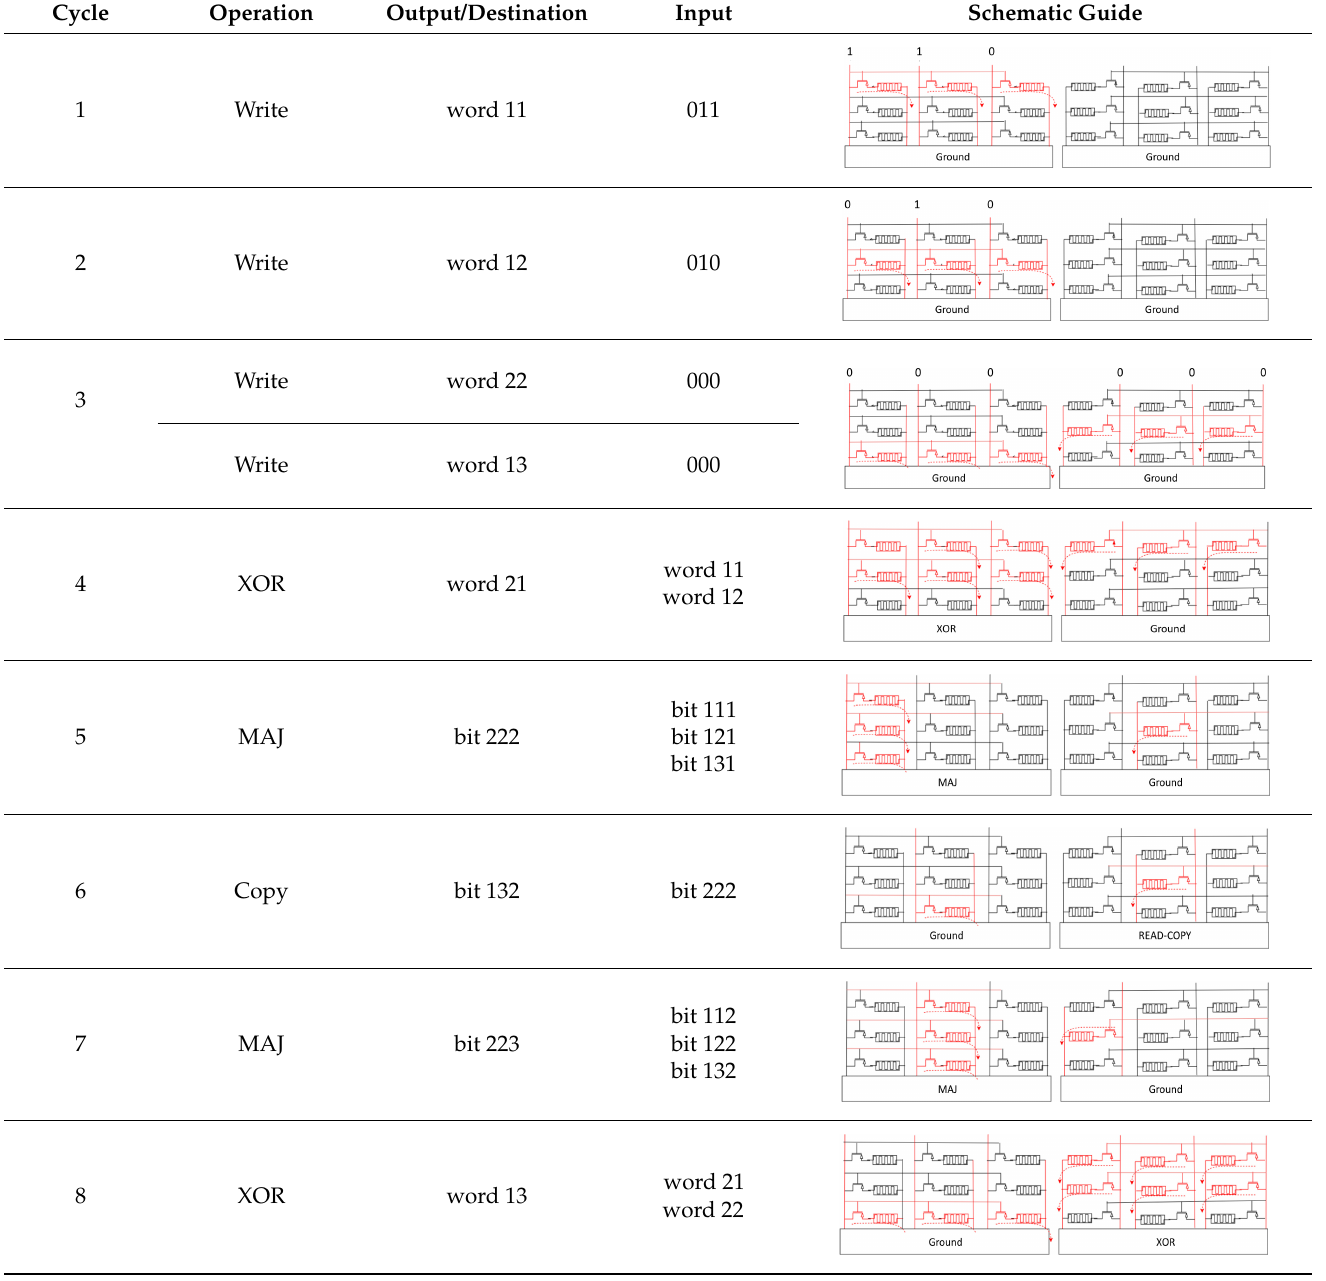
the result of Sum with another XOR operation performed in crossbar 2 with the contents Table 3. Summary of simulated computational steps required to perform the binary addition. Table 3. Summary of simulated computational steps required to perform the binary addition. Table 3. Summary of simulated computational steps required to perform the binary addition. Table 3. Summary of simulated computational steps required to perform the binary addition. Table 3. Summary of simulated computational steps required to perform the binary addition. Table 3. Summary of simulated computational steps required to perform the binary addition. Table 3. Summary of simulated computational steps required to perform the binary addition. Table 3. Summary of simulated computational steps required to perform the binary addition. Table 3. Summary of simulated computational steps required to perform the binary